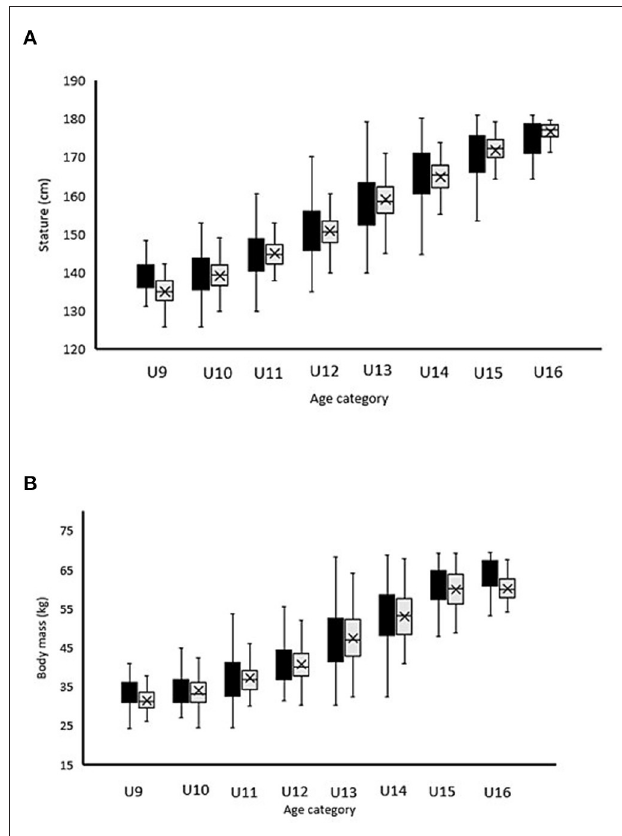
FIGURE 6 | Mean ± SD for anthropometric [ (A) stature; (B) body mass] characteristics of 812 UK academic soccer players according to the traditional categorization based on chronological age (black bars) vs. the newly proposed reallocation method (gray